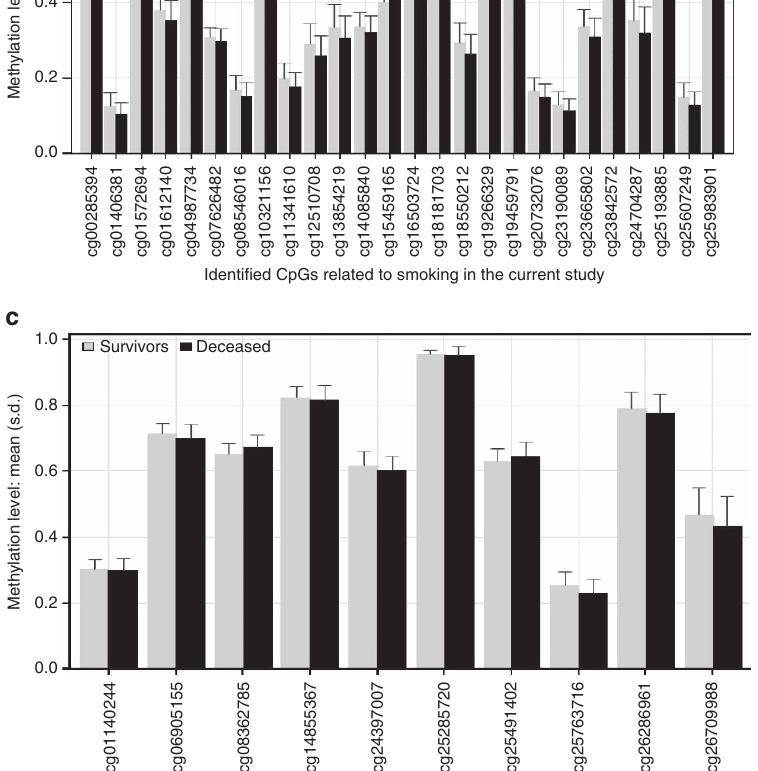
Figure 1 | Methylation levels of 58 CpGs among deceased ( N ¼ 231) and survivors ( N ¼ 769) in the validation panel of the ESTHER cohort. ( a ) Mean and s.d. (error bar) of 22 mortality-related CpGs (also discovered to be associated with smoking in both current and previous studies) by vital status; ( b ) mean and s.d. (error bar) of 26 mortality-related CpGs (also discovered to be associated with smoking in the current study) by vital status; ( c ) mean and s.d. (error bar) of other 10 mortality-related CpGs by vital status.